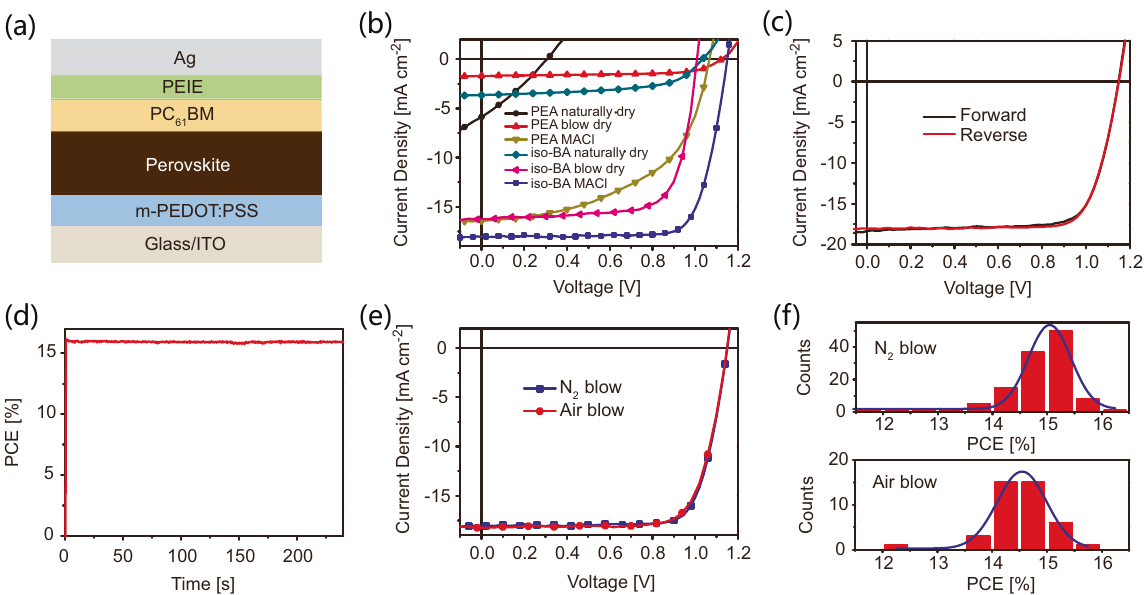
Fig. 6 Device performance of perovskite solar cells prepared using different conditions. a Device structure of the quasi-2D perovskite solar cells; b J – V curves for the PEA-2D and iso-BA-2D perovskite solar cells prepared by natural drying, and N 2 blow-drying with and without MACl additive; c J – V curves for the ‘ champion ’ cell under reverse and forward scan; d PCE obtained using MPP tracking; e J – V curves for the ‘ champion ’ cells prepared by drying under N 2 or air streams; f statistics of the PCE distribution for iso-BA-2D perovskite solar cells prepared by drying under N 2 or air